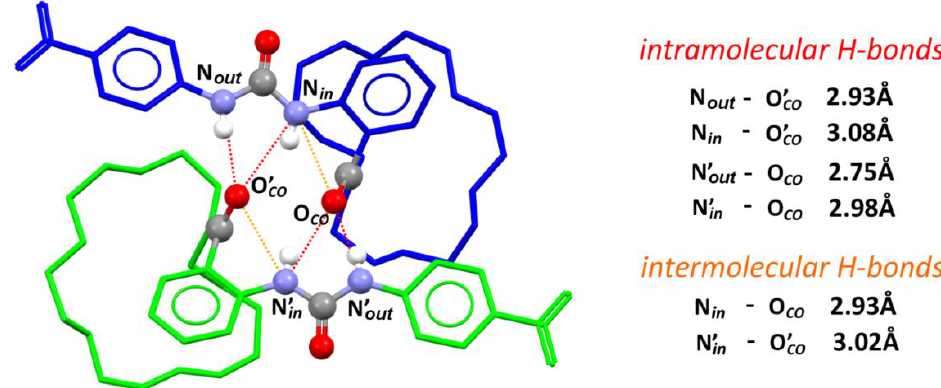
Figure 4. The crystal structure of dimer formed by receptors 1 in the solid state: Conformers A and B are colored in green and blue, respectively; urea and carbonyl groups are presented as balls in common colors; solvent molecules, most of hydrogen atoms, and disorder are omitted for clarity; selected hydrogen bonds are presented as dashed lines connecting corresponding donor and acceptor